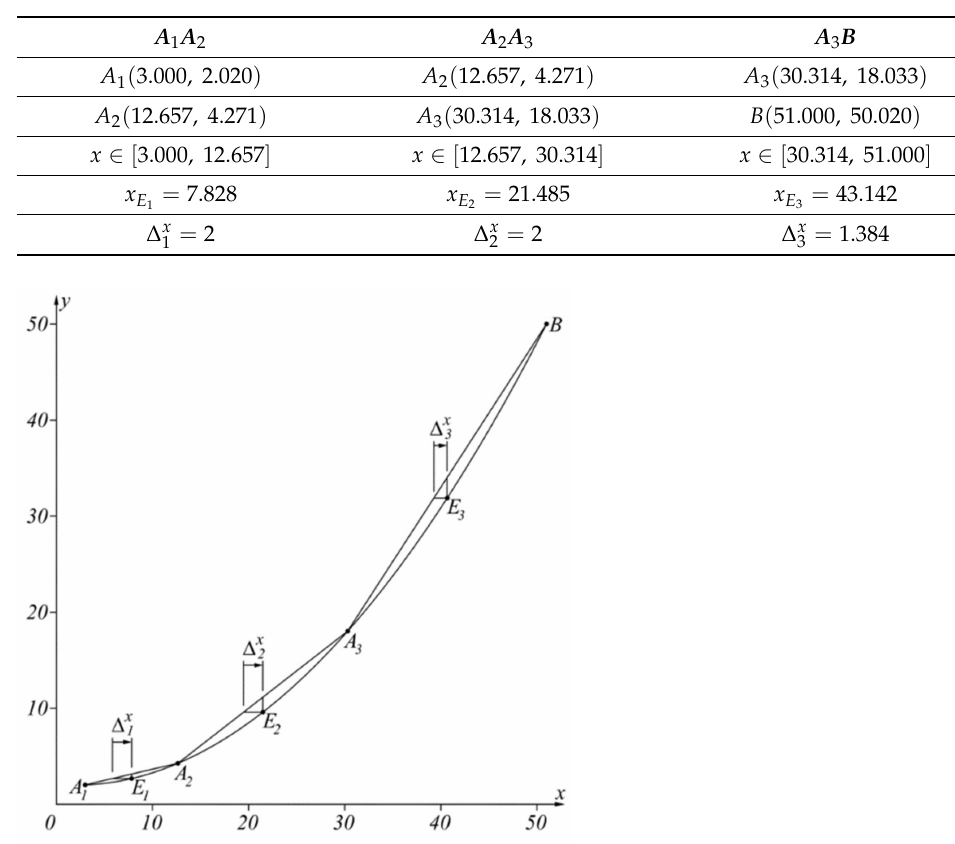
Table 1. Results of the solution of the illustrative example.